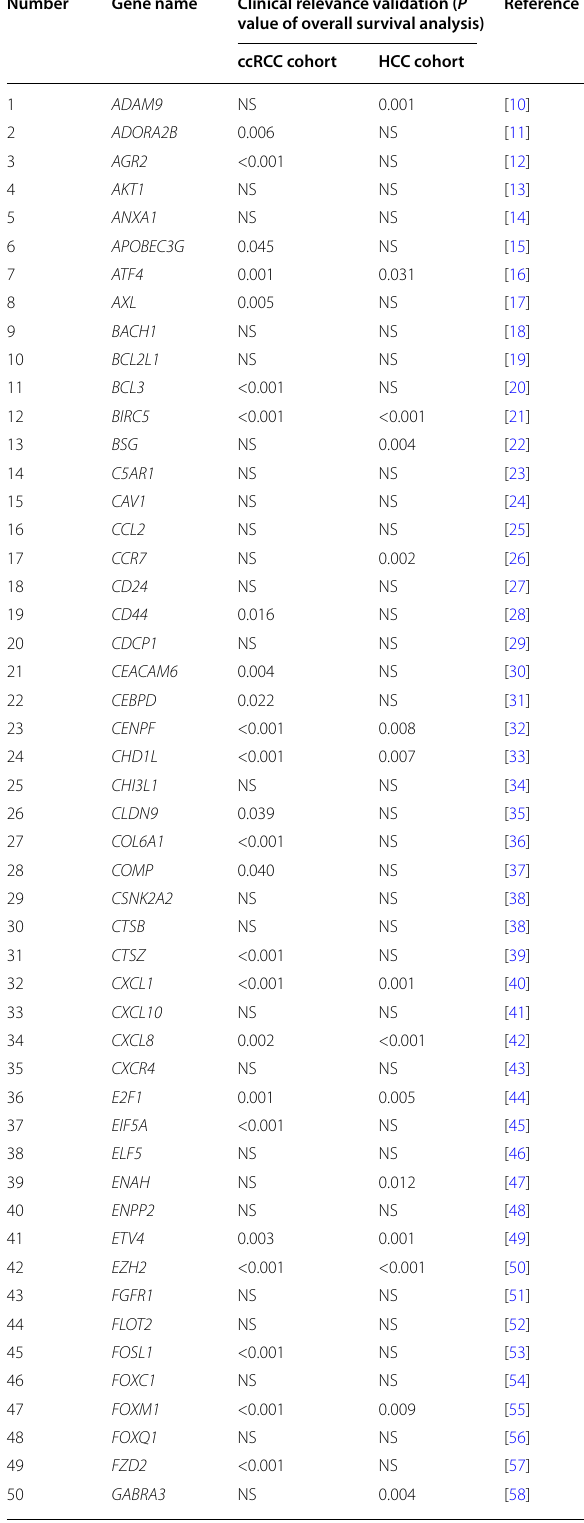
Table 1 The list of 150 pro-metastatic genes with clinical relevance and key